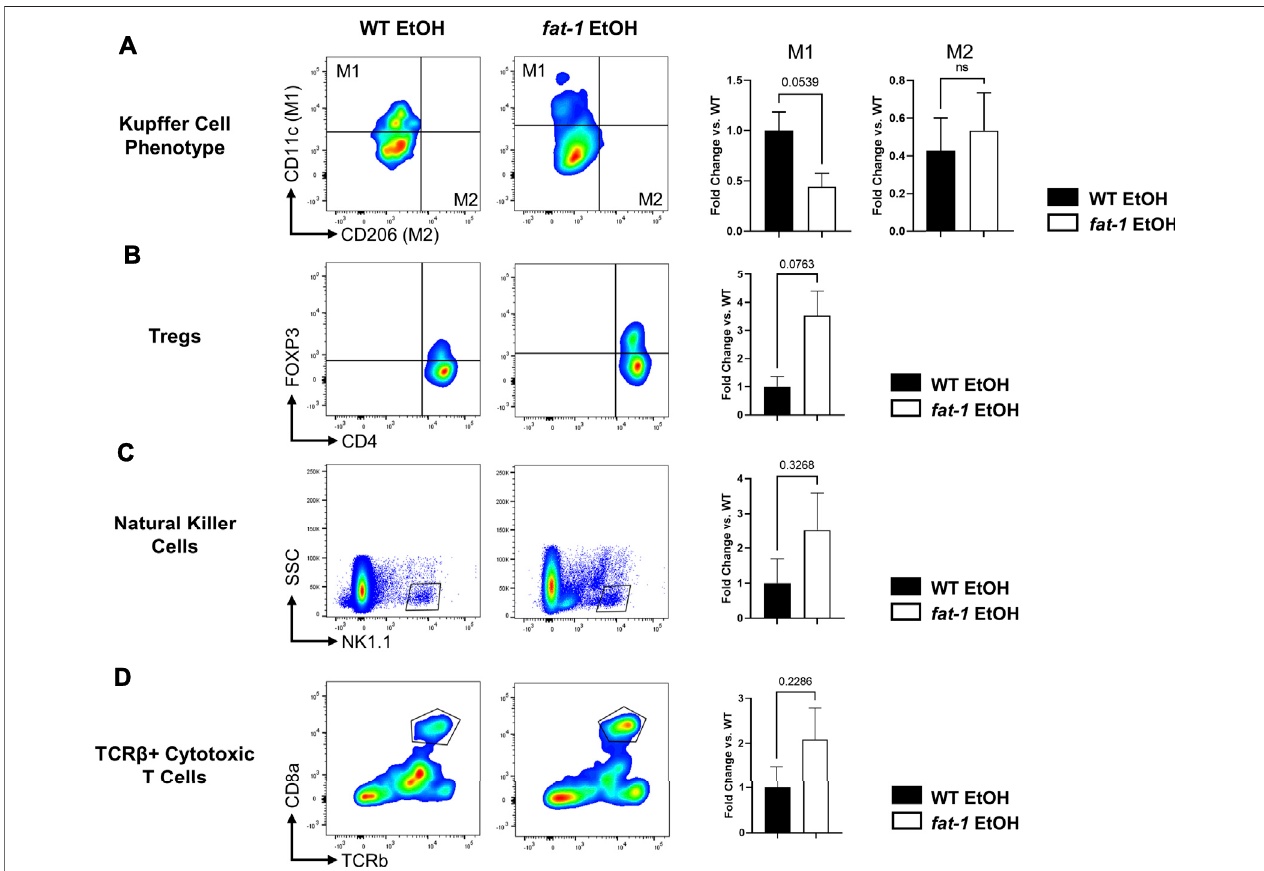
FIGURE 6 | Flow cytometry analysis of hepatic immune cells following EtOH feeding. Abundance of (A) M1 and M2 KCs, (B) T regulatory cells, (C) Natural killer cells, and (D) TCR β + killer cells. *, p < 0.05, two-tailed Student ’ s t test. Results are an average of n (cid:1) 3 – 4 mice per group.